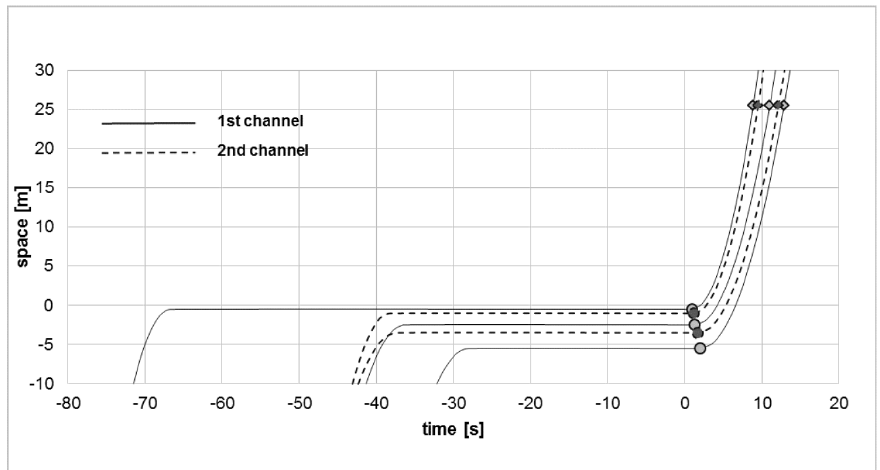
Figure 4. Space-time diagrams of cyclists in the Q(5,2) multichannel queue